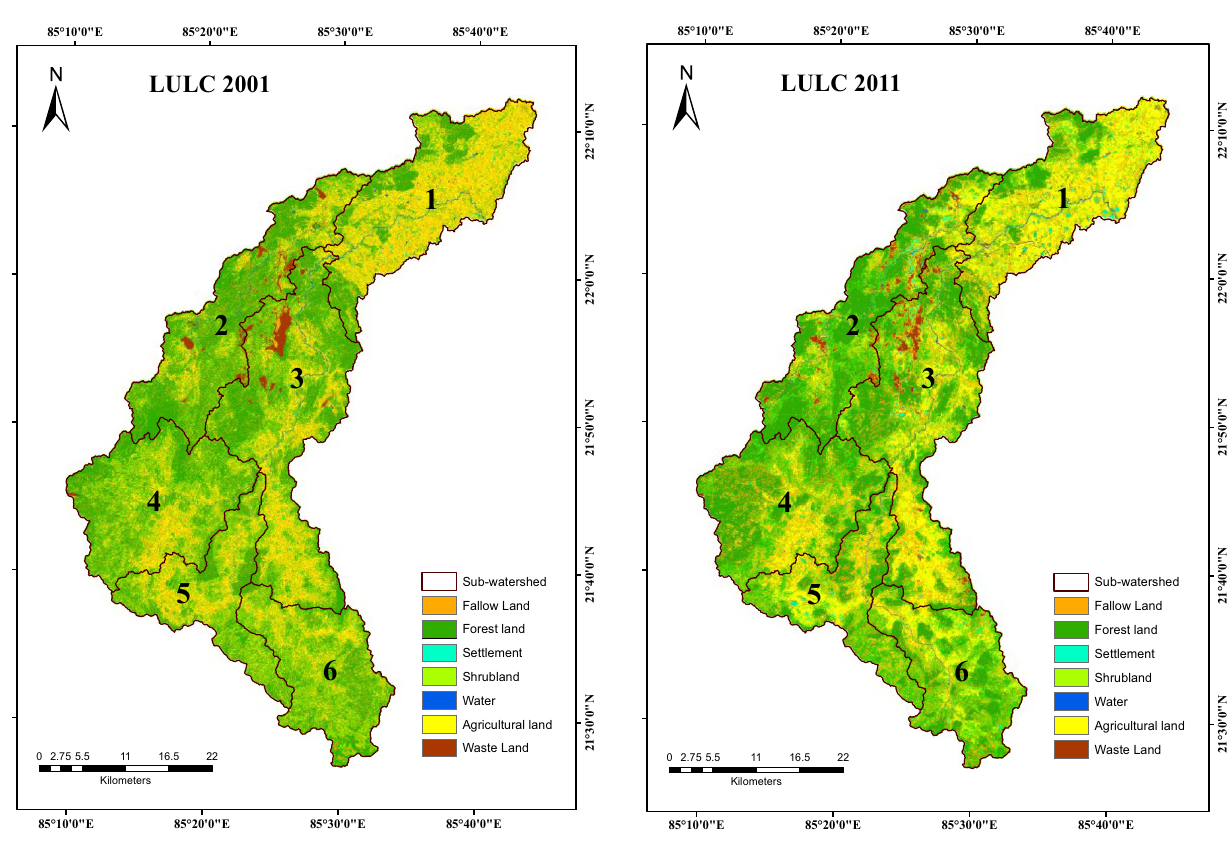
Fig. 4 LULC (2001) and LULC (2011) maps of Champua watershed for Baitarani River Table 5 LULC change analysis from 2001 to 2011 for the whole Champua watershed